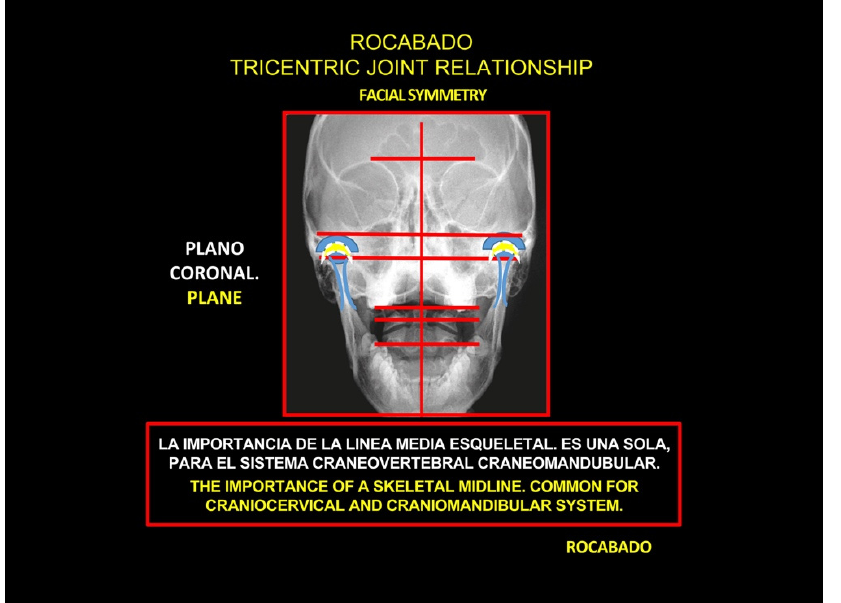
Figure 3. Rocabado tricentric